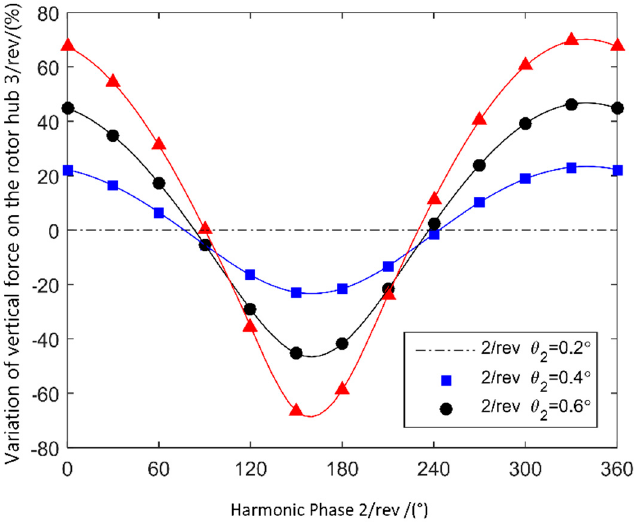
Figure 19. The variation of the average component of the vertical force on the rotor with the phase of the second-order harmonic.